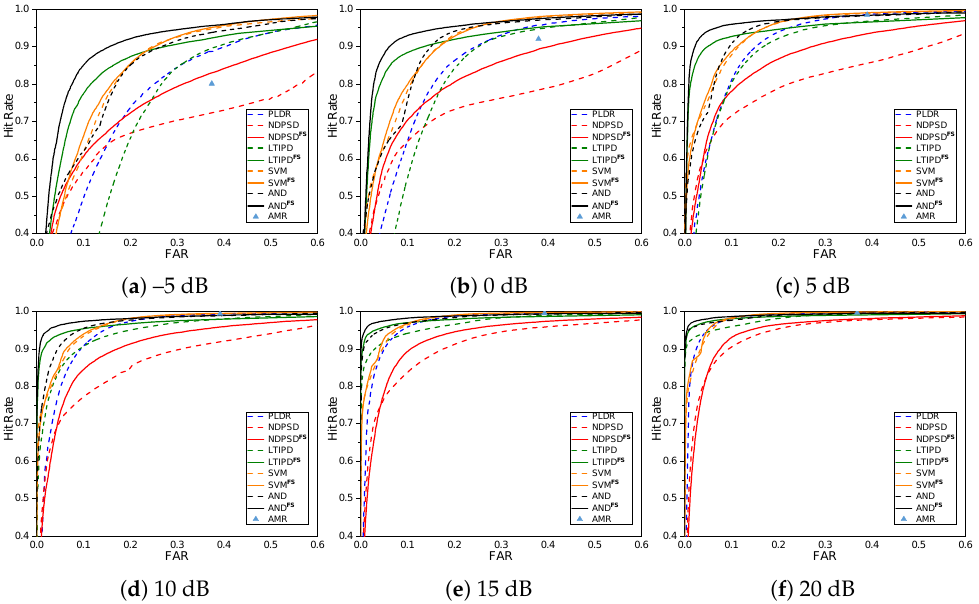
Figure 2. Receiver operating characteristics curves for various voice activity detection (VAD) with and without the proposed frequency selective approach.